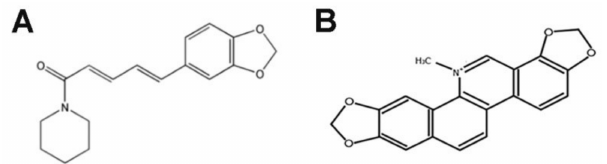
Figure 1. Chemical structures of piperlongumine ( A ) and sanguinarine ( B )